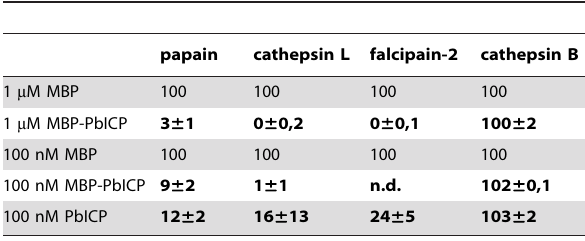
proteases but not of cathepsin